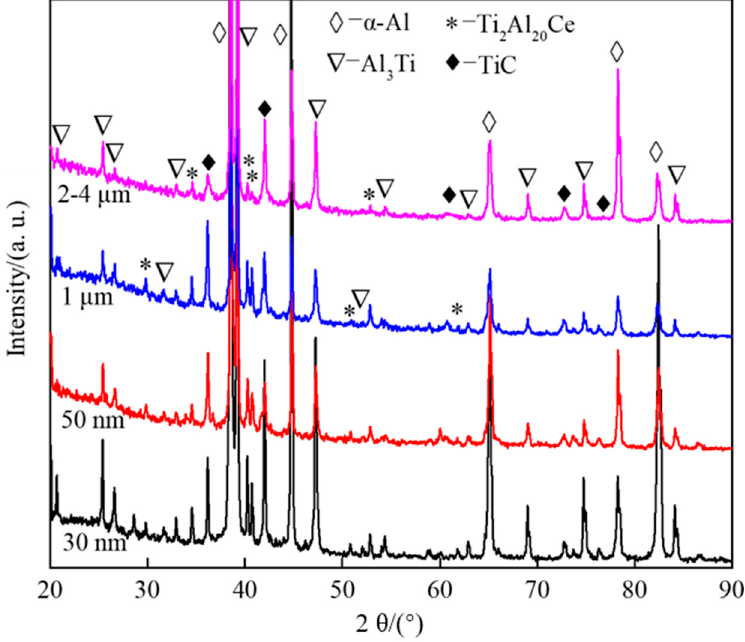
Figure 5. XRD patterns of prefabricated blocks with different CeO 2 size under complete reaction.